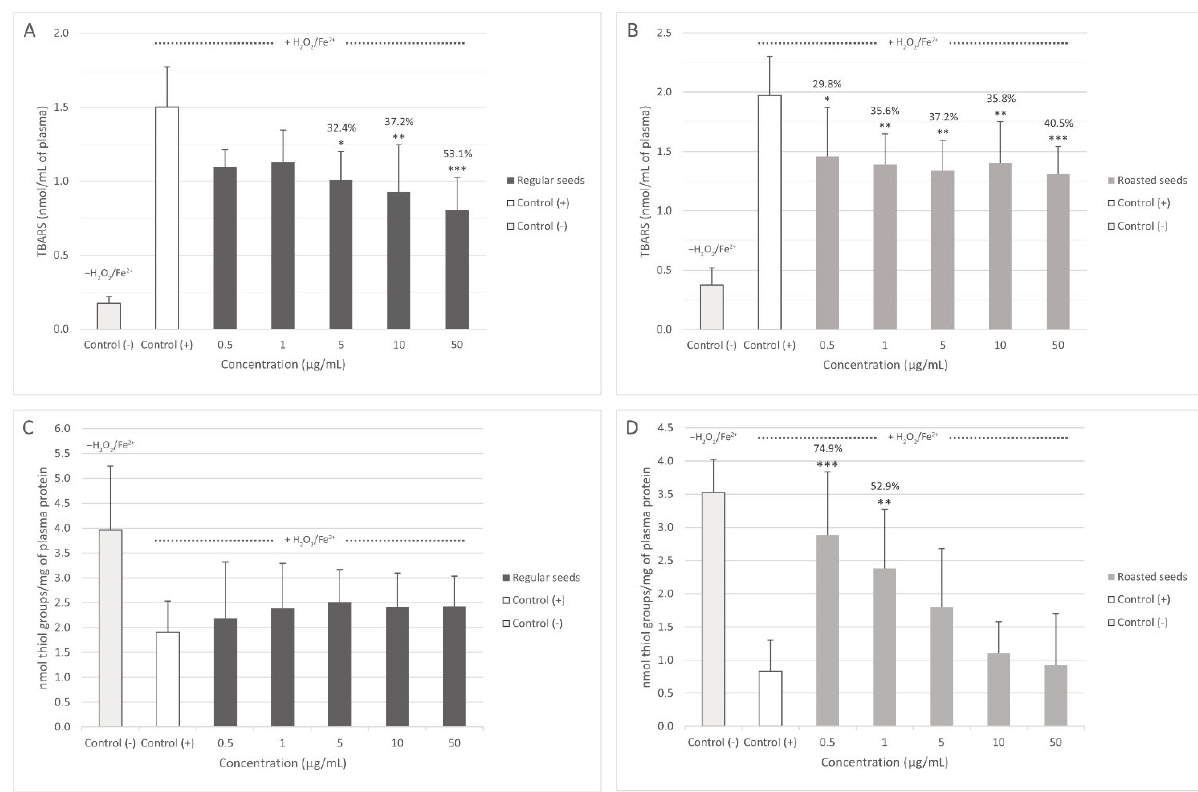
Figure 2. Effect of the extracts from regular ( A , C ) and roasted ( B , D ) sea buckthorn seeds on the level of thiobarbituric acid reactive substances (TBARS) and on the level of thiol groups in human plasma treated with Fe 2+ /H 2 O 2 ( n = 8). Control (+) and test samples (0.5–50 μ g/mL) were incubated (30 min, 37 °C) with Fe 2+ /H 2 O 2 —an oxidative stress inducer. The results are presented as nmol TBARS/mL of plasma ( A , B ) and the results are also presented as nmol thiol groups/mg of plasma protein ( C , D ). The data are expressed as means ± SD. The results were considered significant at p < 0.05 (* p < 0.05; ** p < 0,01; *** p < 0.001). The numbers above significant results are % of lipid peroxidation inhibition.